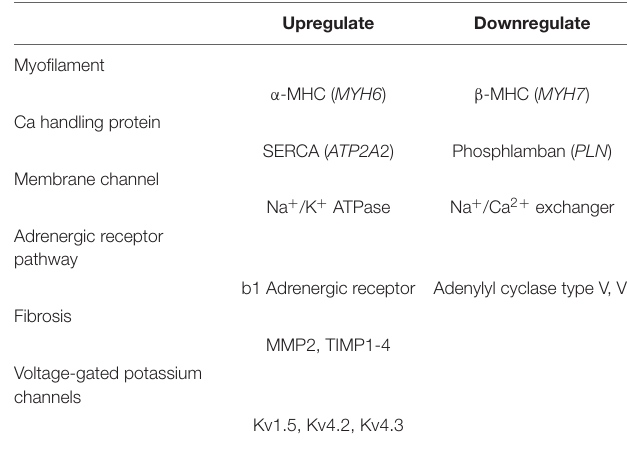
TABLE 2 | Regulation of the genes coding for cardiac proteins by THs [modified from reference (Klein and Ojamaa,